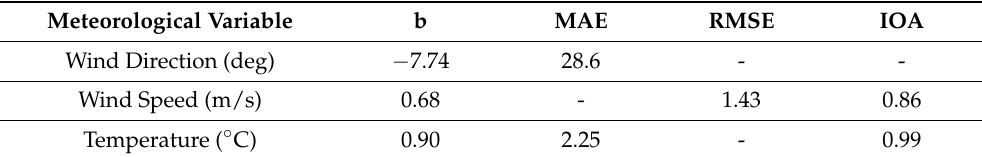
Table A3. 2011 Statistics for WRF Extracted Points Compared to Observations at Minneapolis–Saint Paul International